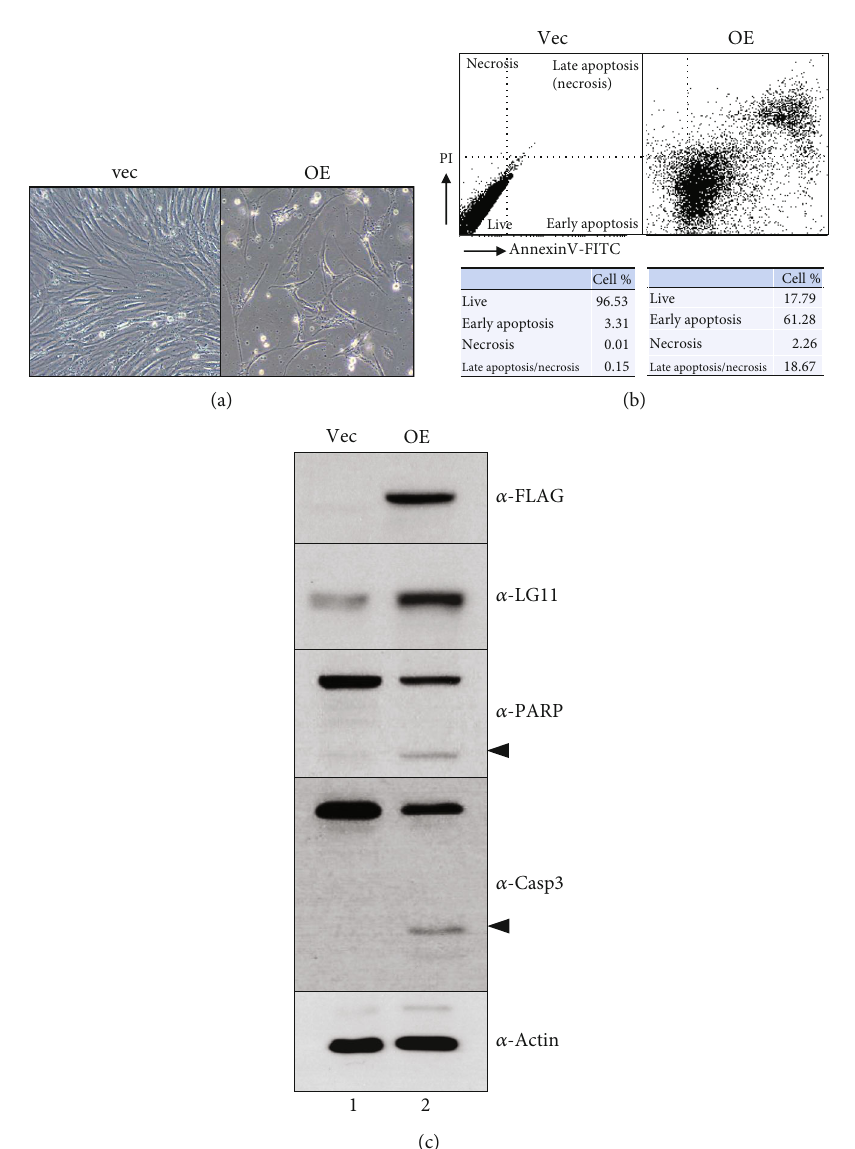
Figure 6: The overexpression of GOLGA5 induces the programed cell death. (a) Morphological changes of GOLGA5 overexpressed hPDLSC. (b) FACS analysis by double staining of PI and annexin V. (c) Activation of apoptotic marker proteins. The ectopic expression of GOLGA5 was detected by anti-FLAG antibody (a-FLAG). The activated fragments of PARP and caspase-3 were indicated by arrowheads. Lane 1: transfection with vector only (vec); lane 2: transfection with GOLGA5 cDNA construct